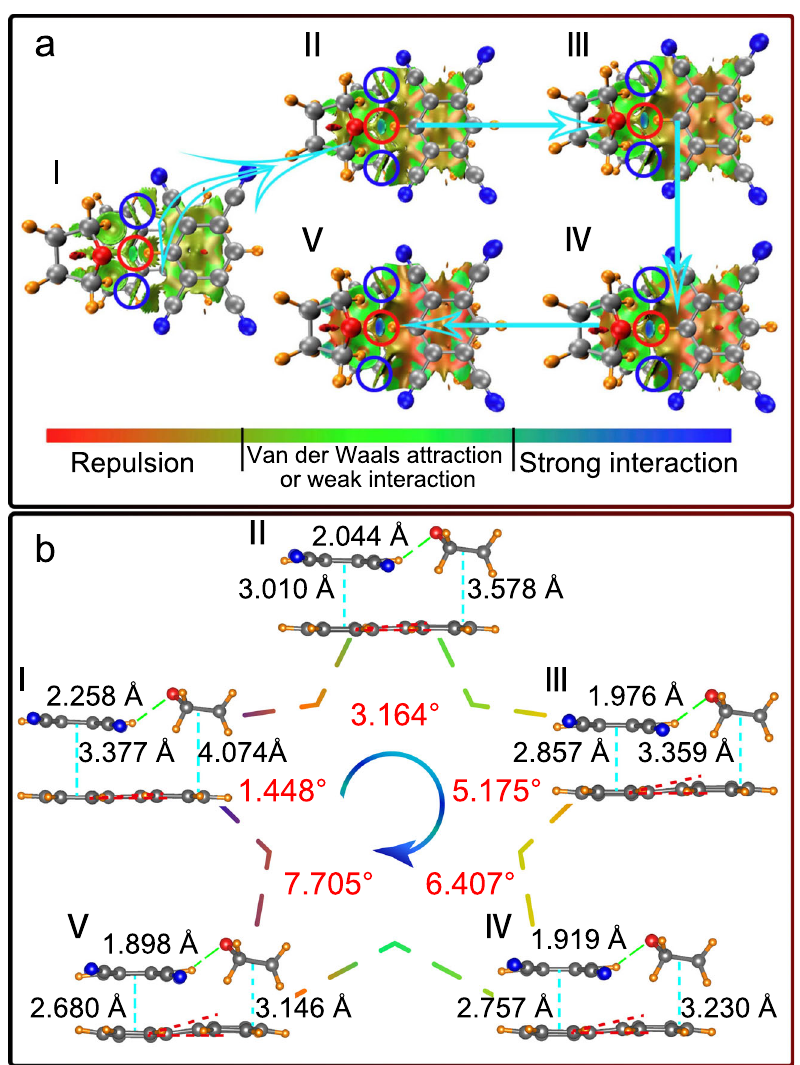
Fig. 6 NCI and molecular con fi gurations analysis. a NCI analysis of PTC – THF at different pressures. The hydrogen bond strength of C – H···O is highlighted by red circles, while the blue circles indicate that Van der Waals forces still exist between TCNB and THF. b The molecular con fi gurations at different pressures. The angle (red number) represents the degree of distortion of perylene from 0 to 20 GPa. Roman numerals represent the calculated structure